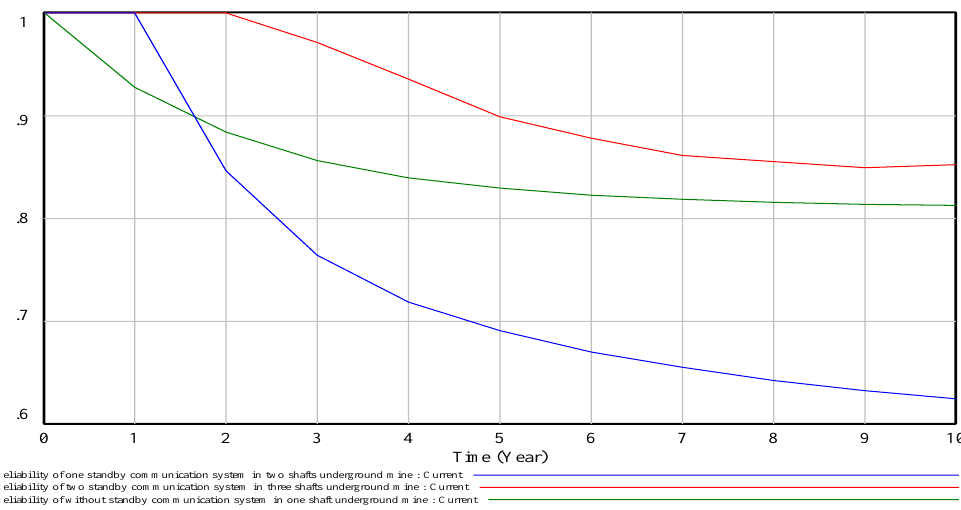
Figure 9. Availability rate of the communication system with a one-, two-, and three-shafts mine. Table 3. Simulation results of one-, two-, and three-shaft underground mine communication system availability.